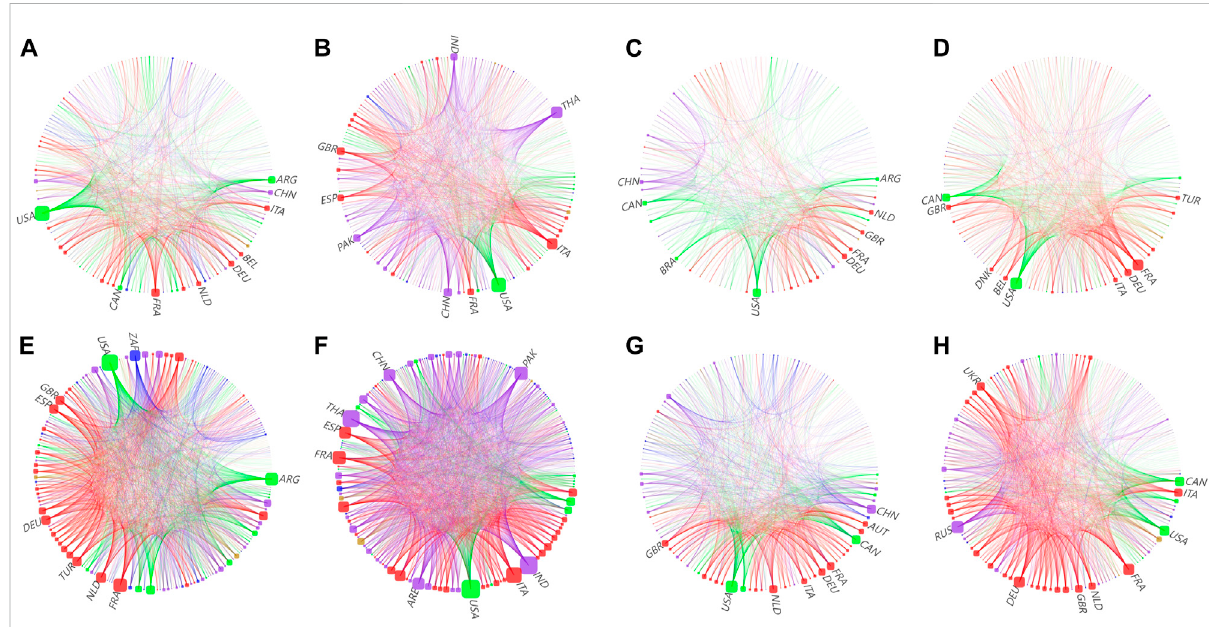
FIGURE 1 Four international crop trade networks (iCTNs) in 1993 (A – D) and 2018 (E – H) . The columns from left to right respectively describe maize, rice, soybean and wheat. For each chordal graph, nodes stand for economies participating in crop trade. The color of nodes is corresponding to different region. Thenodes inbluestand for economiesinAfrica region; thenodesingreenstandfor economiesinAmericaregion; thenodes inpurple stand for economies in Asia region; the nodes in red stand for economies in Europe region and the nodes in brown stand for economies in Paci fi c region. Outgoing links from an economy are shown with the same color as the origin